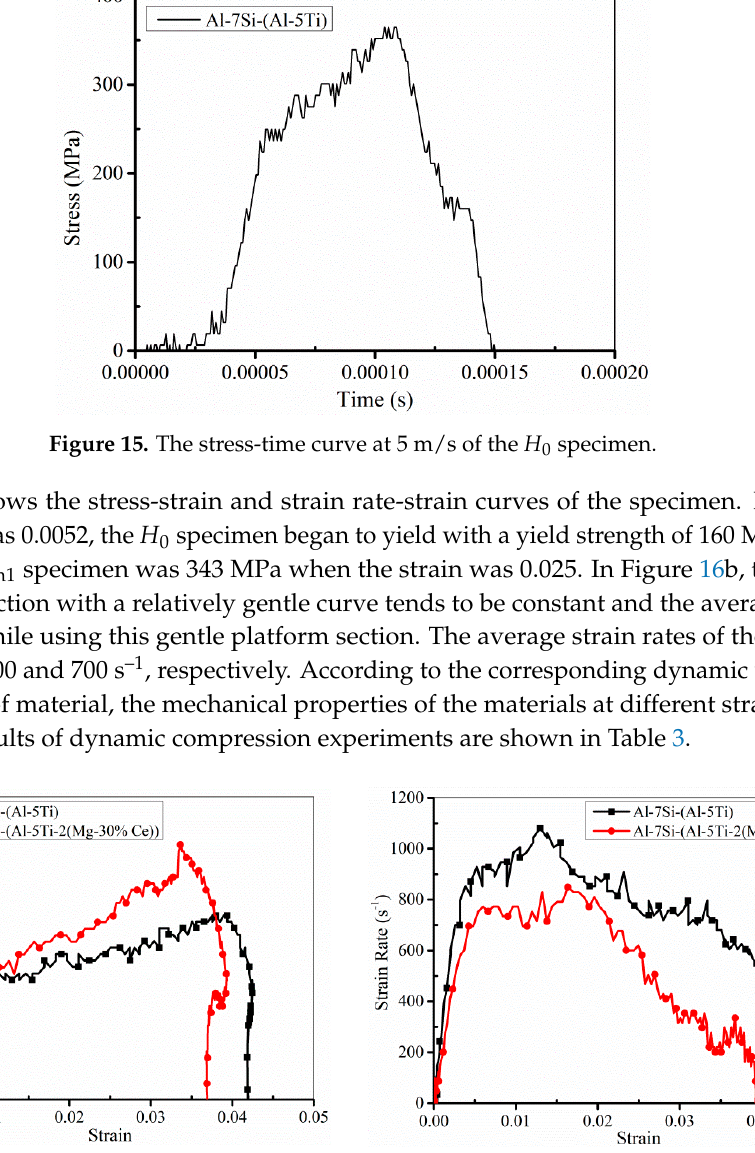
Figure 16. SHPB experiment curve at 5 m/s. Table 3. SHPB experimental data of specimens.